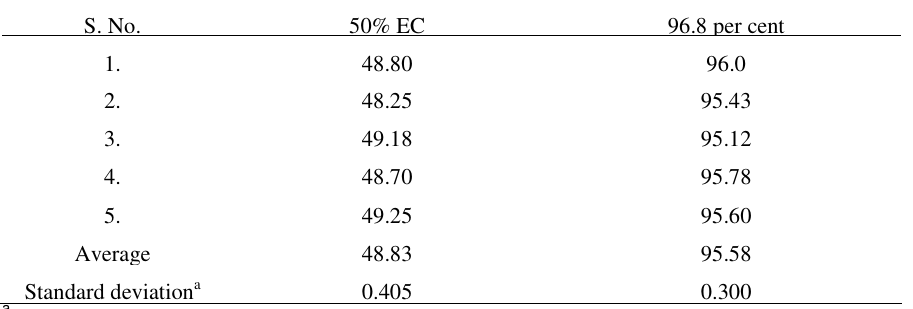
Table 3 Determination of malathion in insecticidal formulations using gention violet as complexing agent S. No.